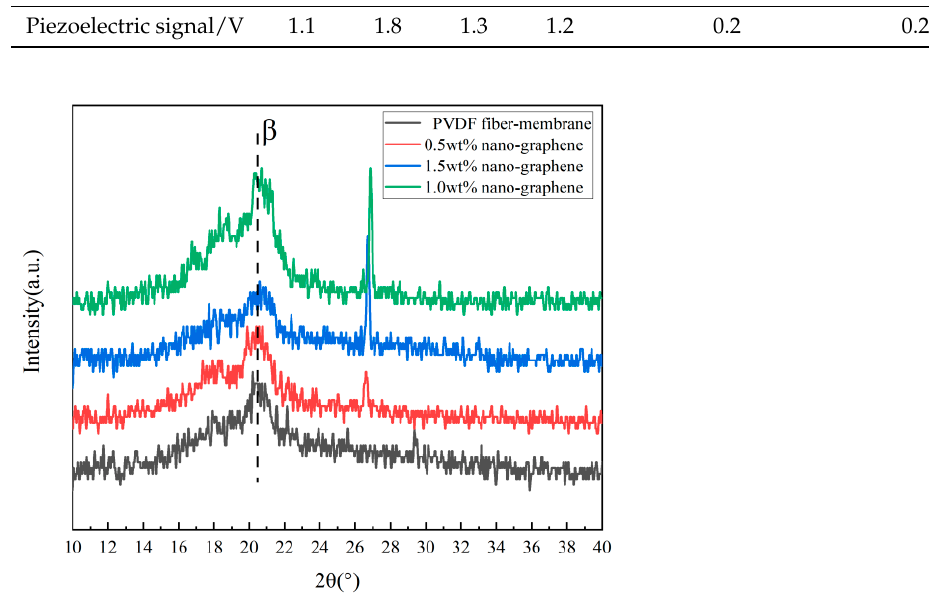
Figure 21. XRD patterns of the P-PVDF fiber membrane, PVDF/nanographene fiber membrane at the addition of 0.5 wt%, 1.5 wt%, and 2.0 wt%.